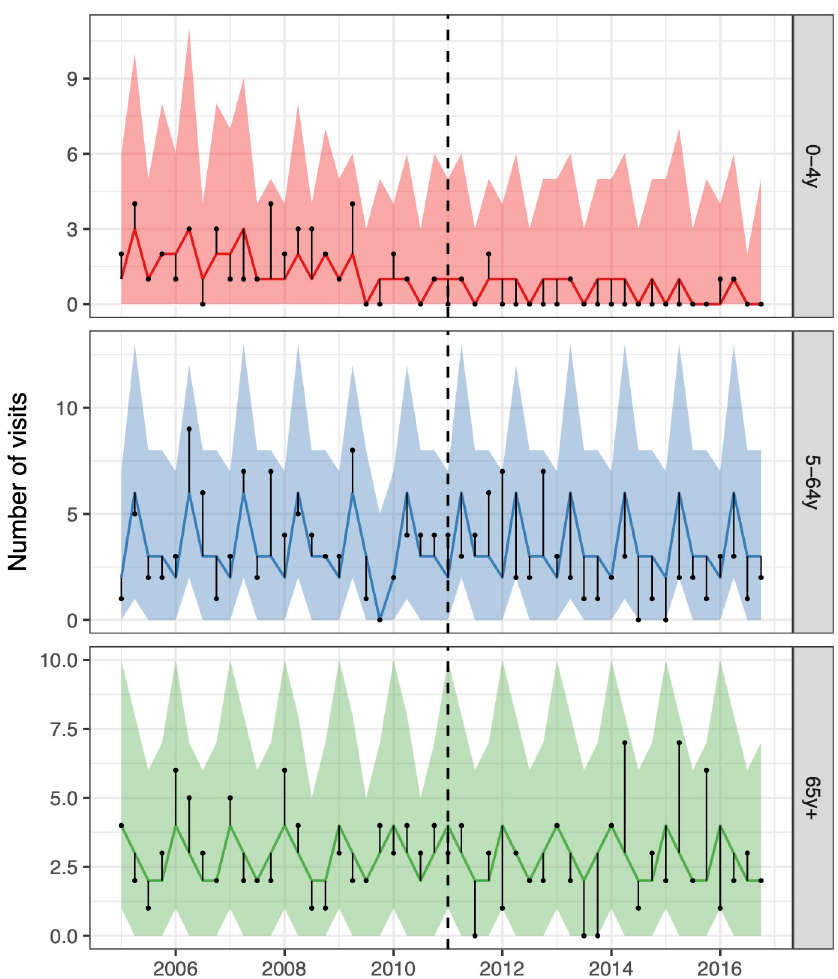
Fig 5. The observed and predicted number of IPD hospitalizations from 1 January 2005 to 31 December 2016 for each age-group. Observed cases are illustrated as black points, and the predicted number of cases are presented as lines with 95% credible intervals as a shaded area. The start of the vaccine period is shown with a vertical black dashed line. The distance between the observed and predicted cases for each year-quarter is depicted by a thin black line. Assuming that the model was correct, and no intervention took place, the black points would have an equal probability of occurring above or below the prediction